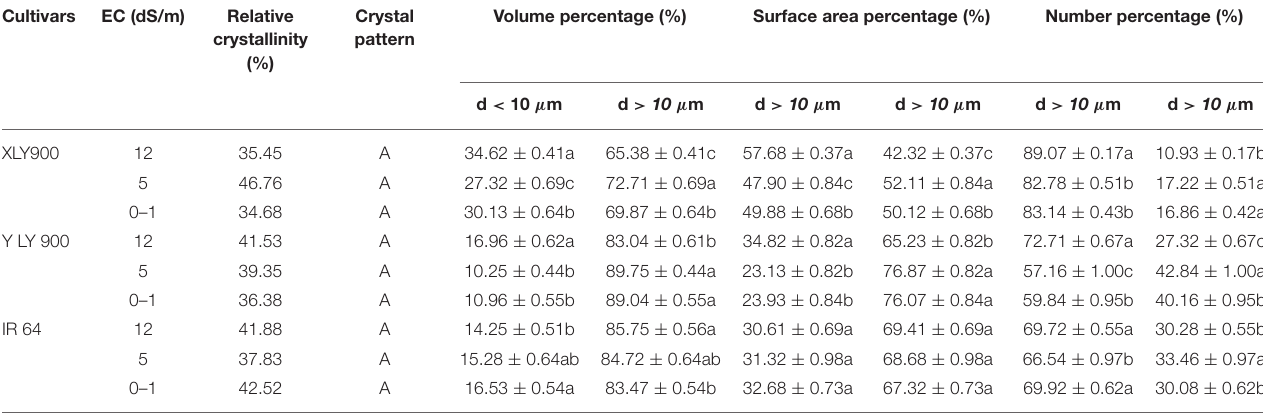
TABLE 2 | Effects of salt stress on starch granule size distribution. Cultivars